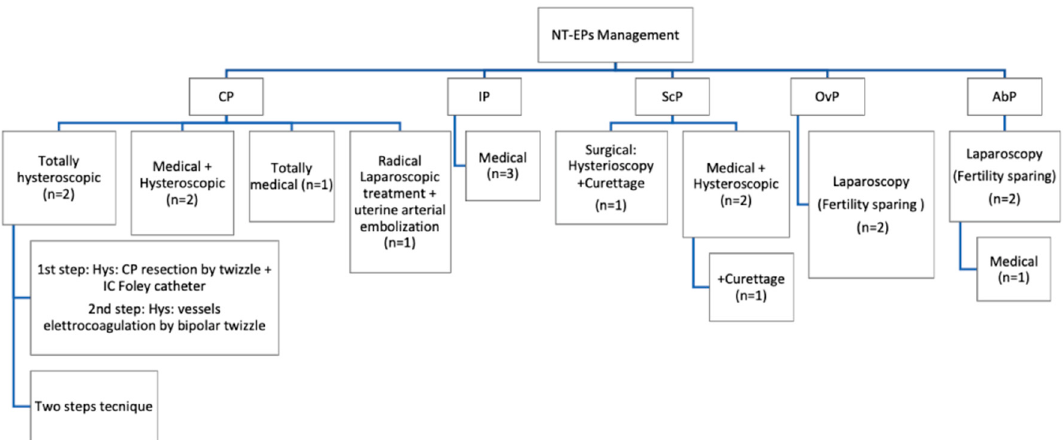
Figure 7. Overview of managment for each type of non-tubal ectopic pregnancy. CP: the medical ( n = 1), hysteroscopic ( n = 2) or the combined approach ( n = 2) were administrated; only in one of the